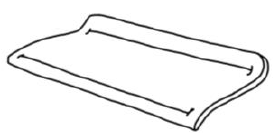
Figure 32. US Patent 007,954,762 B2 Carbon fibre tube as a metal structure [13].